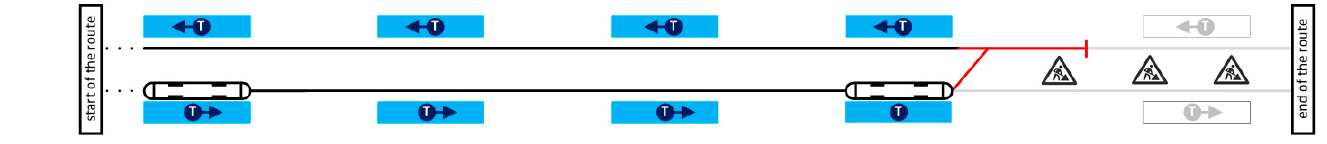
Figure 14. Using the bi-directional tram to serve a tram route in repair.